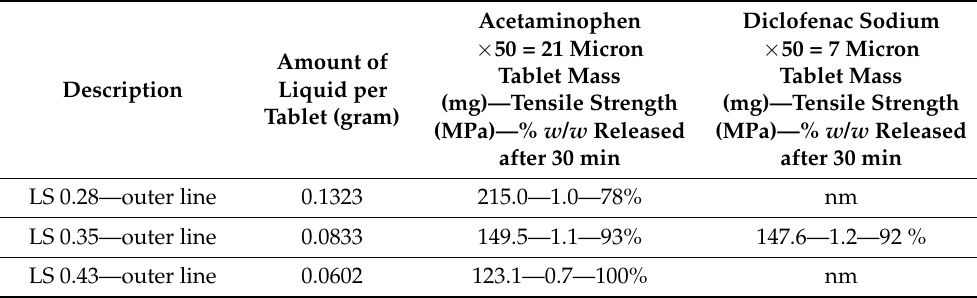
Table 3. Tablet tensile strength versus release after 30 min for tablets printed with a diameter of 9 mm and a thickness of 3.1–3.6 mm (corresponding to 7 layers). nm = not measured. Formulations contain 10% API, 20%, starch and 70%